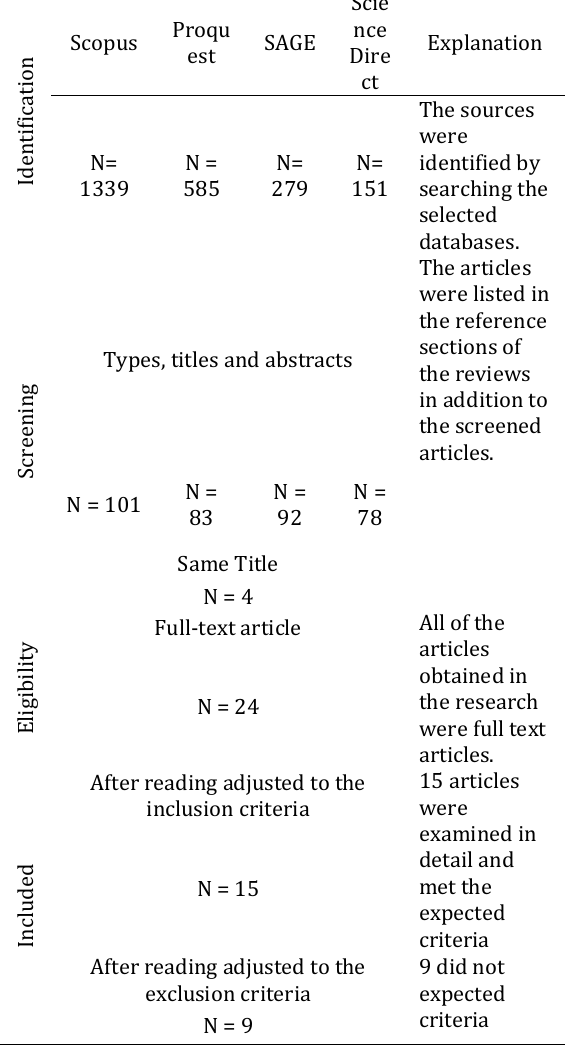
Table 1. Literature Search